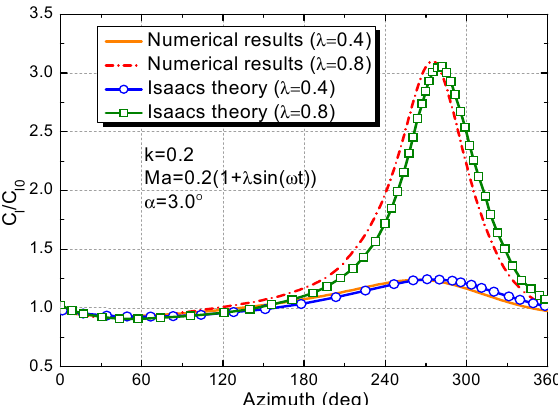
Figure 5. Comparison of simulated results with Isaacs’s theory under the oscillating freestream velocity (OFV) condition.